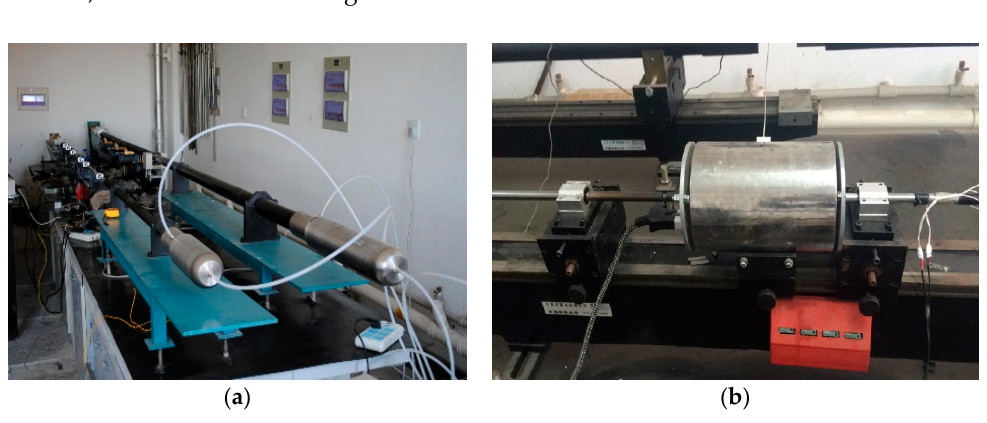
Table 1. chemical composition of AZ31 magnesium alloy.